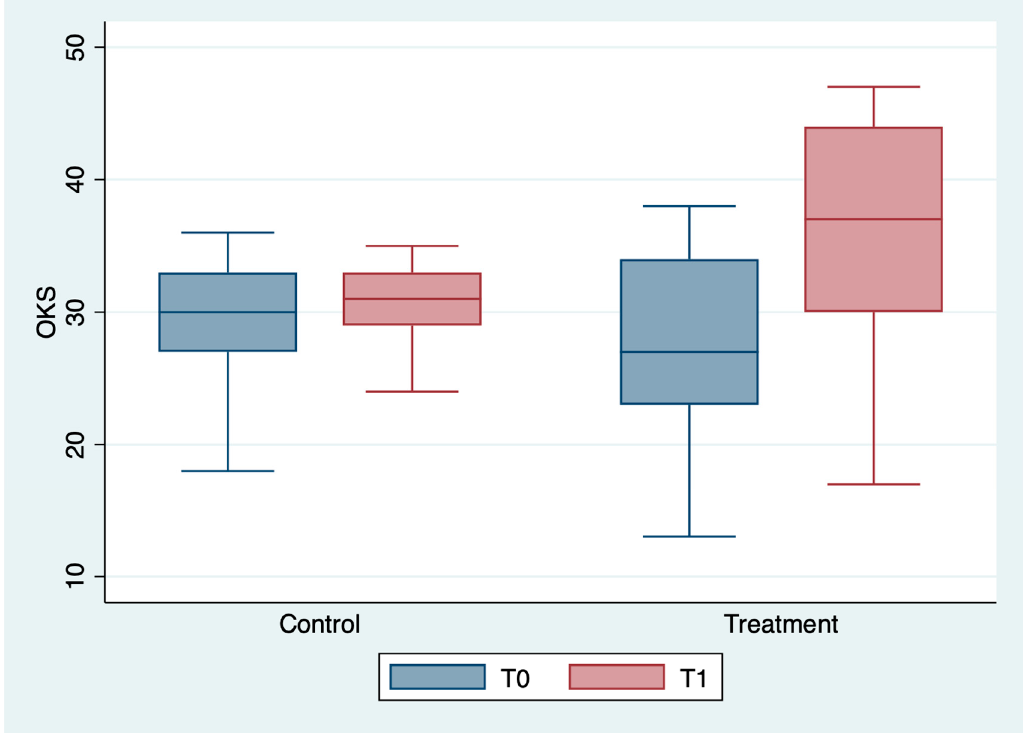
Figure 6. Box plot of OKS values by detection time and group.